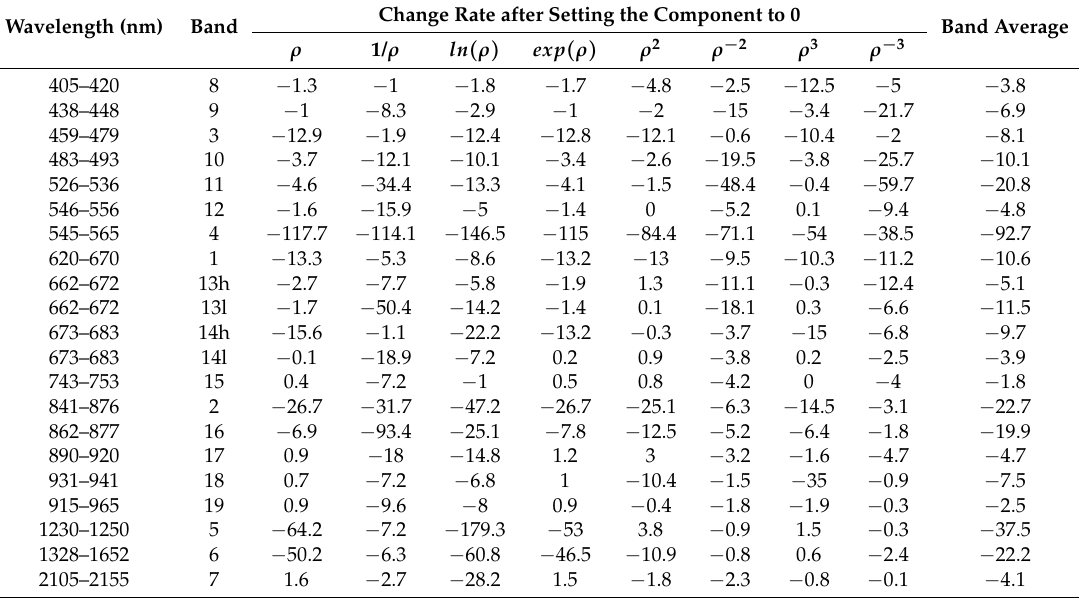
Table 3. Band sensitivity to TP concentration in Lake Okeechobee. Smaller values mean higher sensitivity.